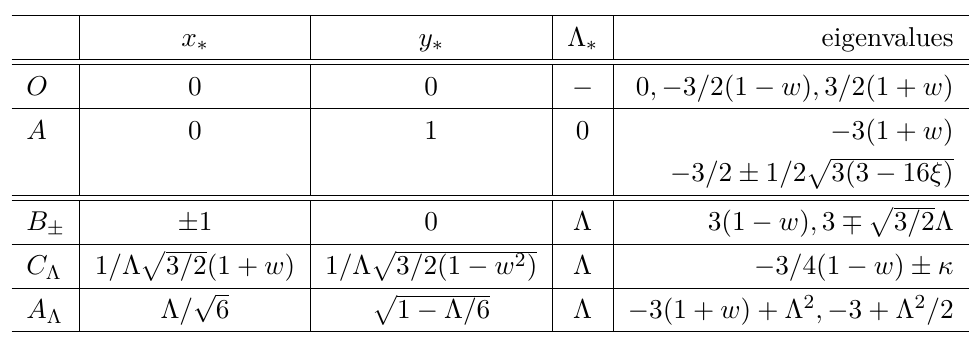
Table 2 . Fixed points of the system (4.11)–(4.13). The quantity κ is given in (4.16). In the column for Λ ∗ , we put a − when Λ is unconstrained by the equations, and a Λ when we ignored equation